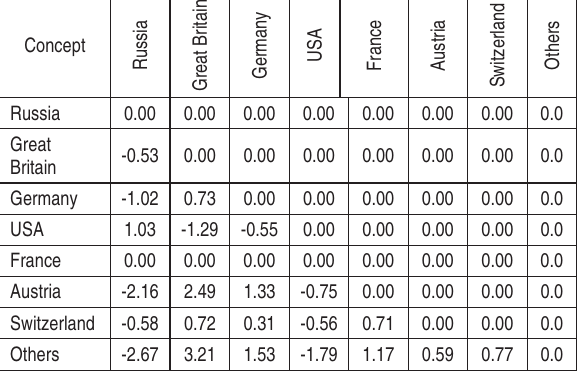
Table 3. Matrix of quantitative assessment of interaction between the concepts of the mechanism for reinsurance regulation according to areas